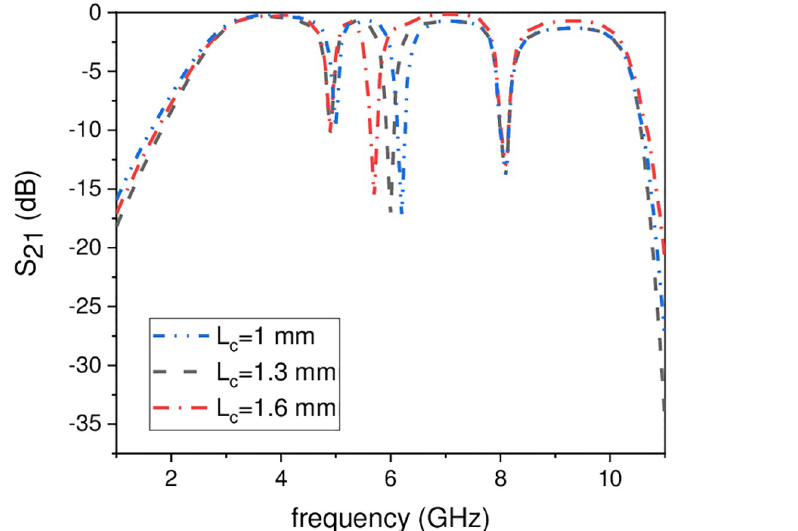
Fig 10. Experimental frequency plot of second NB control by varying Lc.